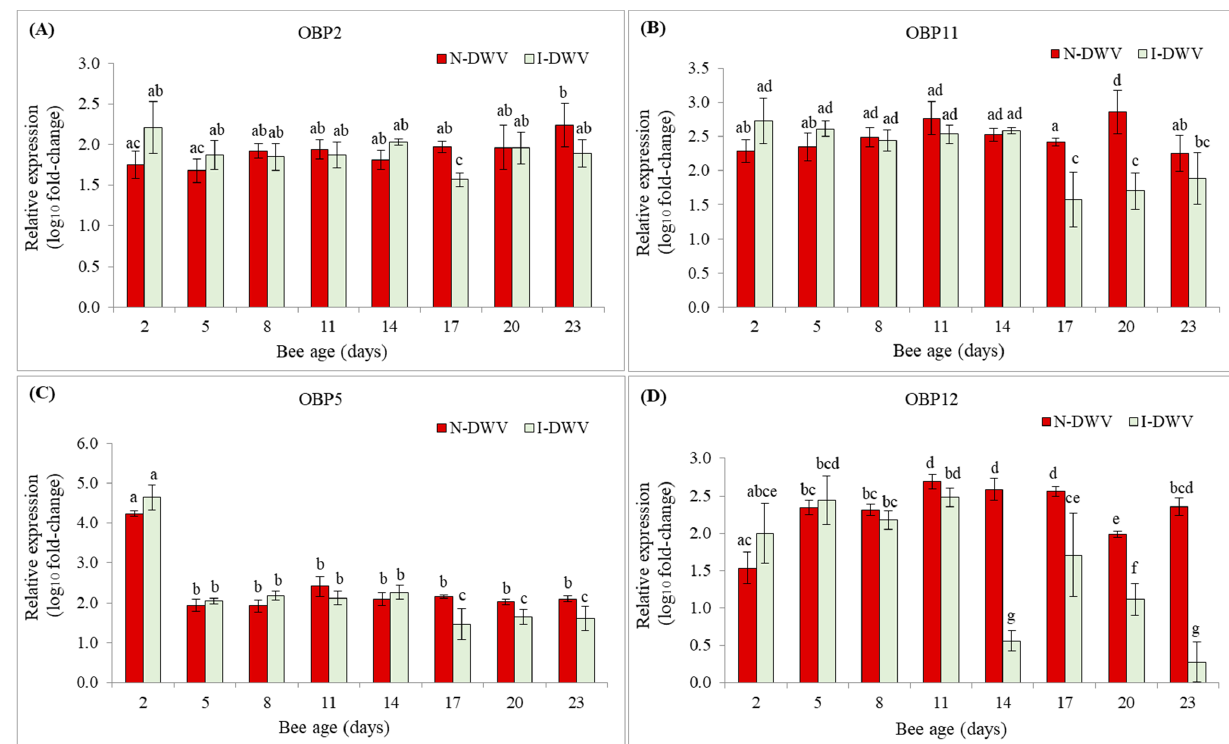
Figure 4. Gene expression of OBPs in worker honey bees of different ages and that were inoculated (I-DWV) and non-inoculated (N-DWV) with DWV-A. Means (±SE) with different letters indicate significant differences according to the Bonferroni test ( p < 0.05) in ( A ) OBP2, ( B ) OBP11, ( C ) OBP5 and ( D ) OBP12.